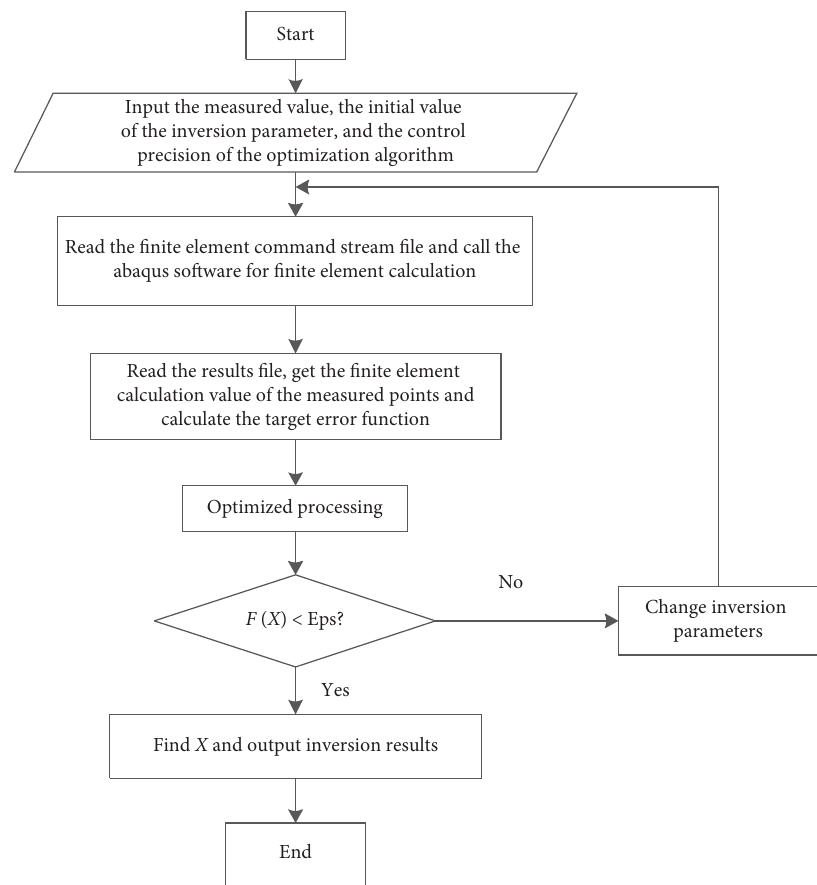
Figure 3: Flowchart of the inversion model combining QGA and finite element